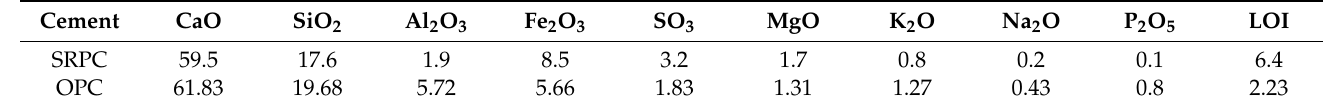
Table 1. Chemical composition of the cement (%).